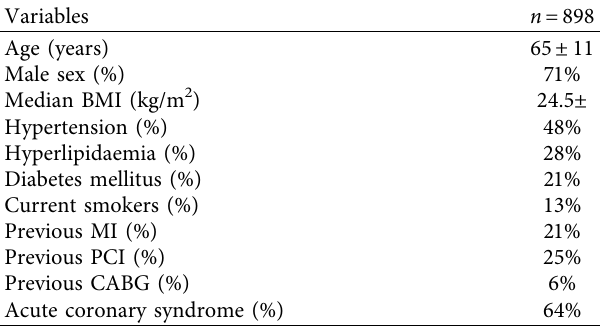
Table 1: Patient demographic and clinical